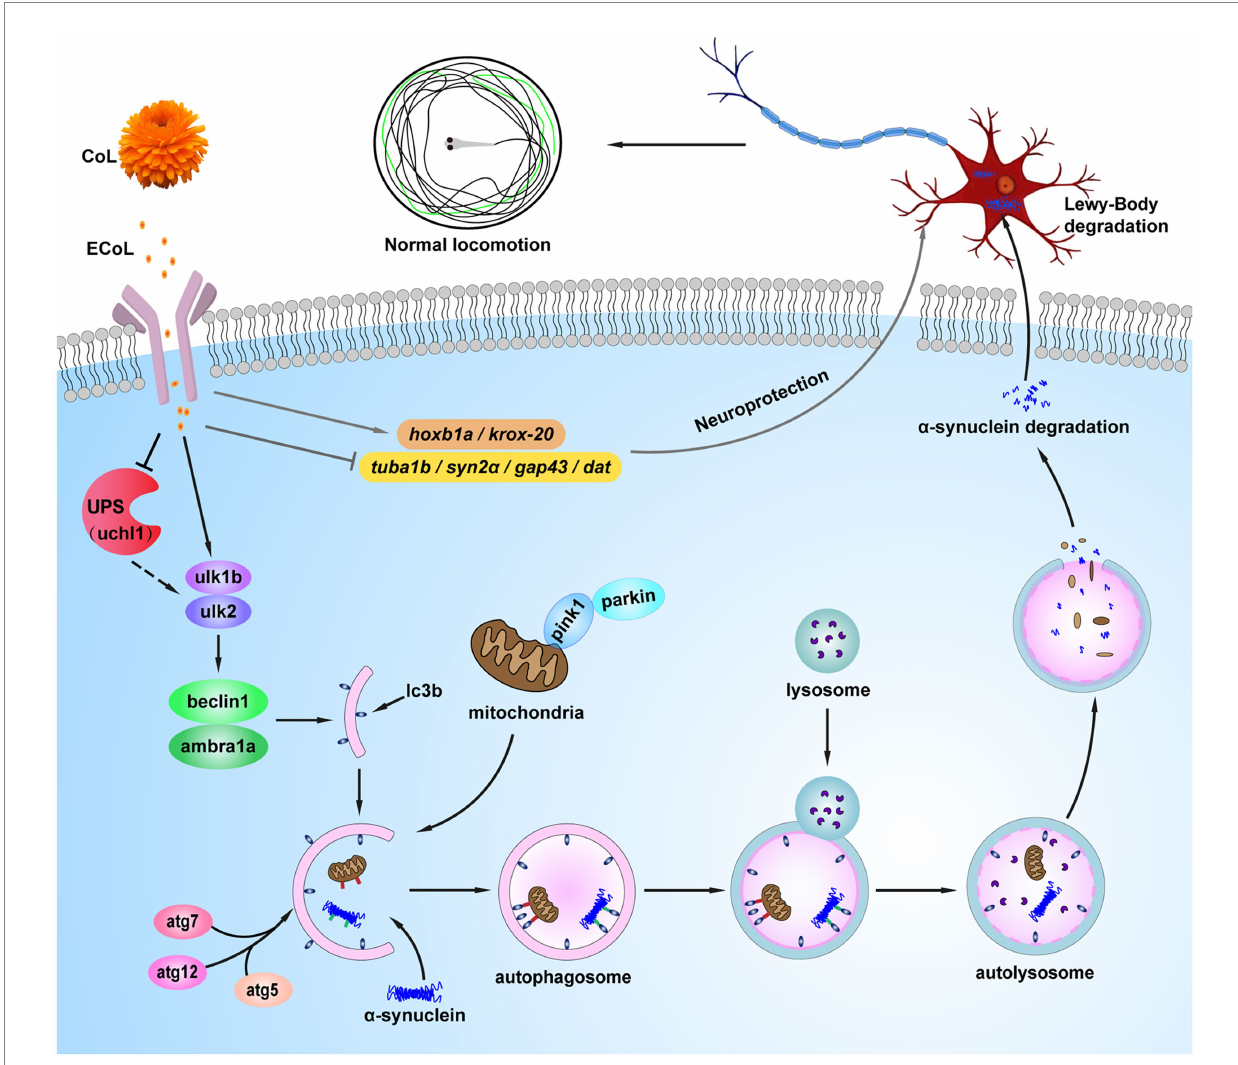
FIGURE 12 The proposed mechanism underlying anti-PD effect of ECoL. ECoL co-treatment can change the abnormal expressions of genes related to neuronal development, contributing to the improvement of neuronal damage in PD. ECoL co-treatment may activate mitophagy and autophagy to degradate the damaged mitochondria and α -synuclein fibrils, further inhibiting the formation of Lewy bodies. Besides, ECoL co-treatment may activate autophagy via inhibiting the function of UPS, or regulate the function of UPS to normal level and meanwhile increase autophagy capacity level. ECoL co-treatment contributes to the cascade of events abovementioned, alleviating the onset and development of